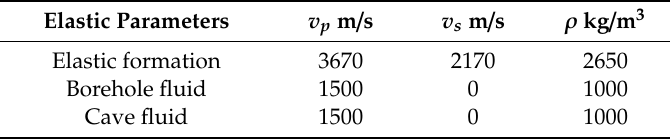
Table 1. Physical parameters of di ff erent